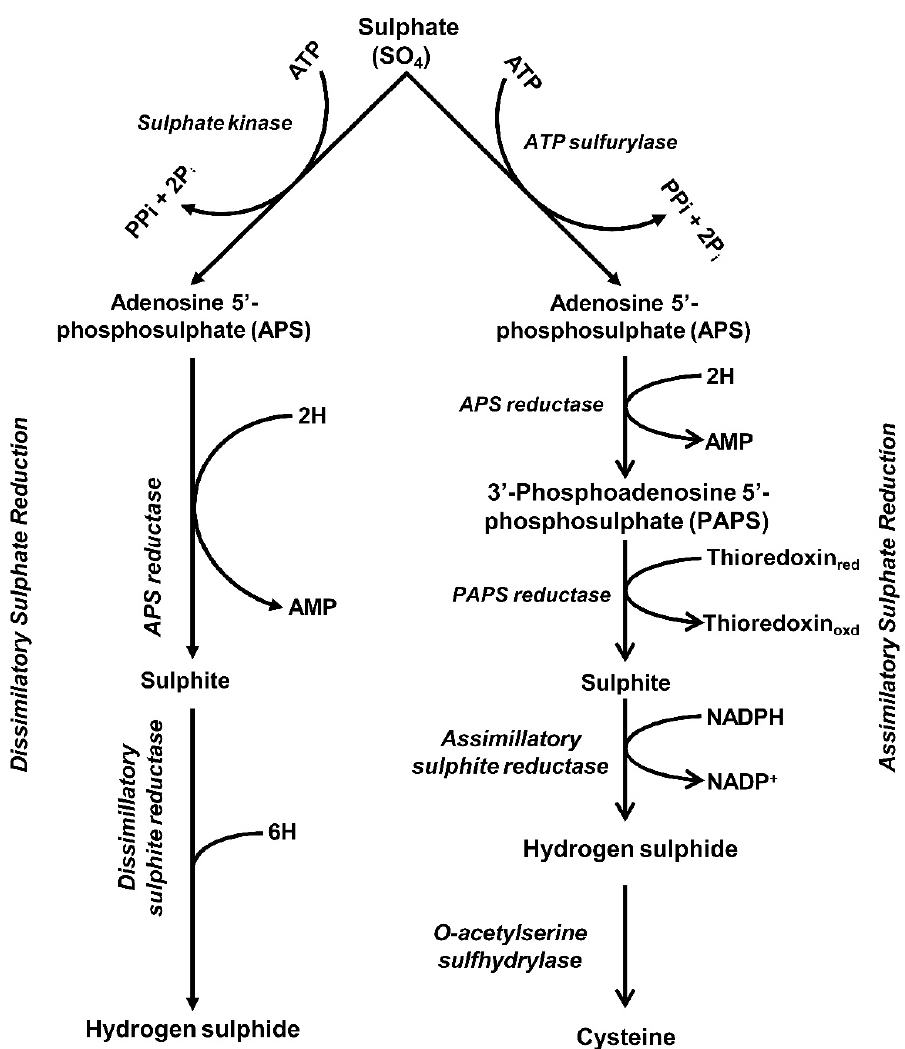
Figure 3. Dissimilatory and assimilatory route of sulfur reduction in rumen. Dissimilatory SRB are strict anaerobic mesophiles, mostly Gram-negative, rod- shaped bacteria [119] that are ubiquitous in the digestive tract of mammals [55,120,121]. Members of the Desulfovibrionaceae (i.e., members of the genus Desulfovibrio ) are the dominant SRB in ruminants [122,123]. Other abundant SRBs have been identified as belonging to the genus Desulfotomaculum and Fusobacterium [119,124]. Inclusion of SRB and/or sulfate in ruminant diet has shown to reduce CH 4 emission and enhance digestibility of the feed (Table 2). The recommended concentration of sulfur in growing beef cattle diet is 0.15% [125] and 0.14 to 0.26% in growing lamb diet [126]. Ruminant diets deficient in sulfur are connected with decreased microbial protein synthesis, digestibility, and lactate use [127,128]. Whanger and Matrone [129] reported microorganisms from sulfur-deficient animal contents could not synthesize butyrate and higher VFAs from acetate. Improved dry matter (DM) digestion, rumen fermentation and bacterial population in sheep fed a high sulfur diet were reported [130]. Patterson and Kung [131] observed adding sulfur at 0.3% DM improved cellulose digestion threefold in in vitro